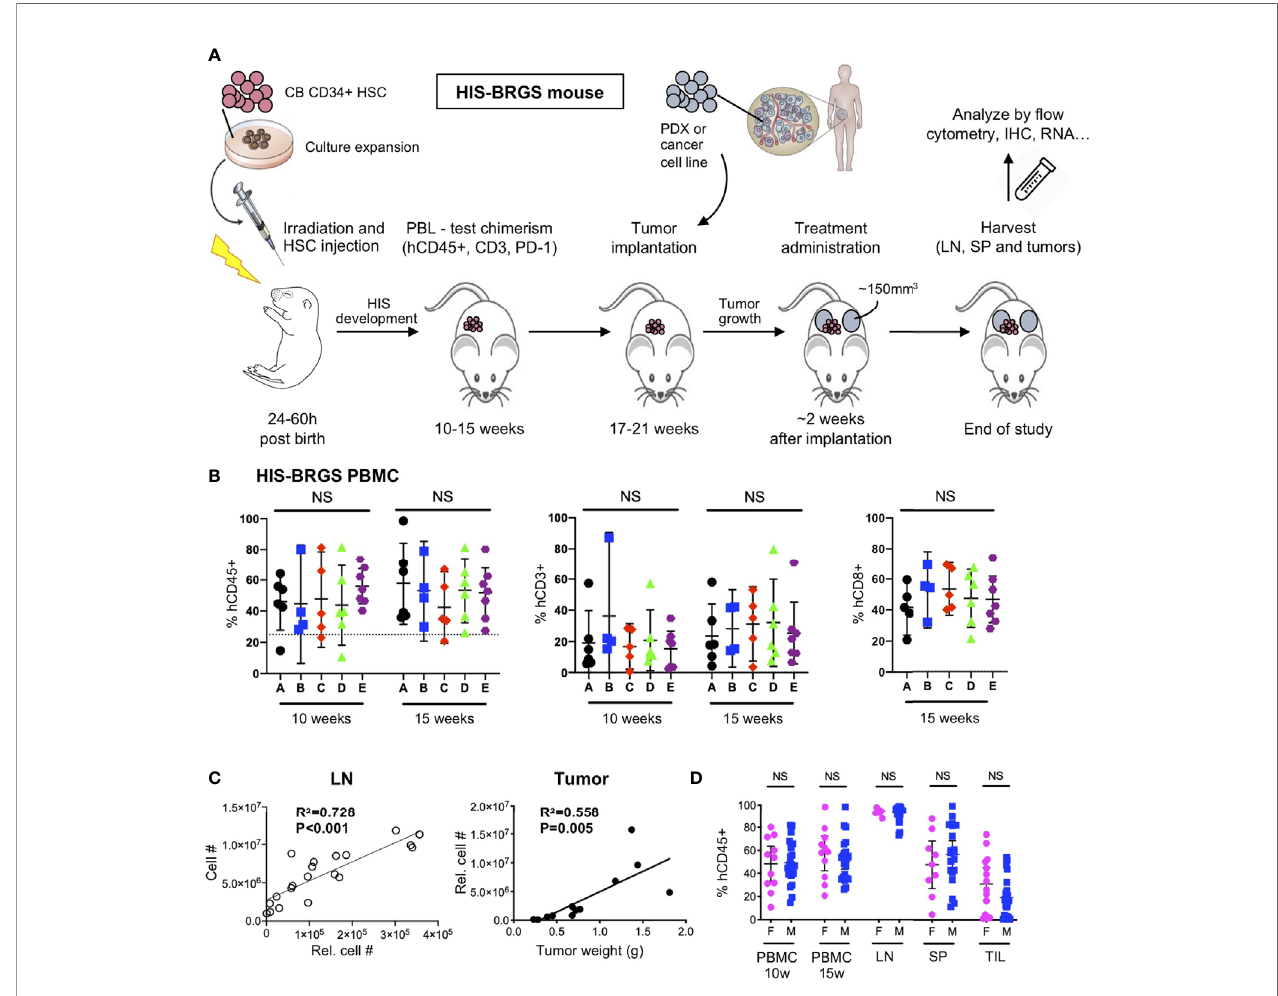
FIGURE 1 | Protocol for evaluation of immunotherapy treatments in HIS-BRGS mice. (A) Timeline of HIS-BRGS mouse model development. (B) Allocation of HIS- BRGS mice into experimental treatment groups A-E based on equivalent human (hCD45+), T (CD3+) and CD8+ T cell chimerism. NS, no signi fi cance [Welch ’ s ANOVA test]. (C) Correlation of cell counts determined by fl ow cytometry (Relative cell count) and hemocytometer cell count in the lymph nodes (LN, left) or tumor weight (right) [linear regression analysis, R-squared score (R2) and P value (P) in bold if statistically signi fi cant (P < 0.05)]. (D) Human (hCD45+) chimerism in the blood (PBMC), LN, spleen (SP) and tumor tissue (TIL) of female (F) vs male (M) HIS-BRGS mice [two-group t-test, two